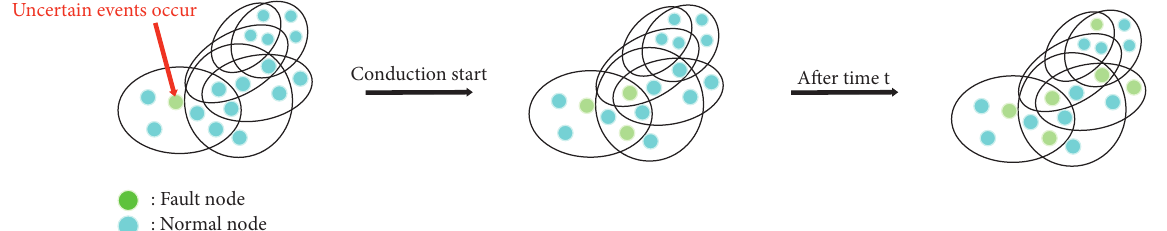
Figure 3: Example of network propagation of uncertain event.